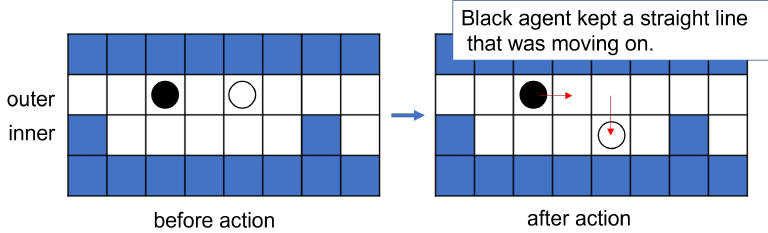
Figure 3. Agents who give way to each other (Black circle is an agent trying to go to the right, white circle is an agent trying to go to the left, the way is given for the agent in black). All walls of the narrow corridor were on the inner side; in a long episode, the orbiting agents would increase the number of collisions in which both agents were on the outer